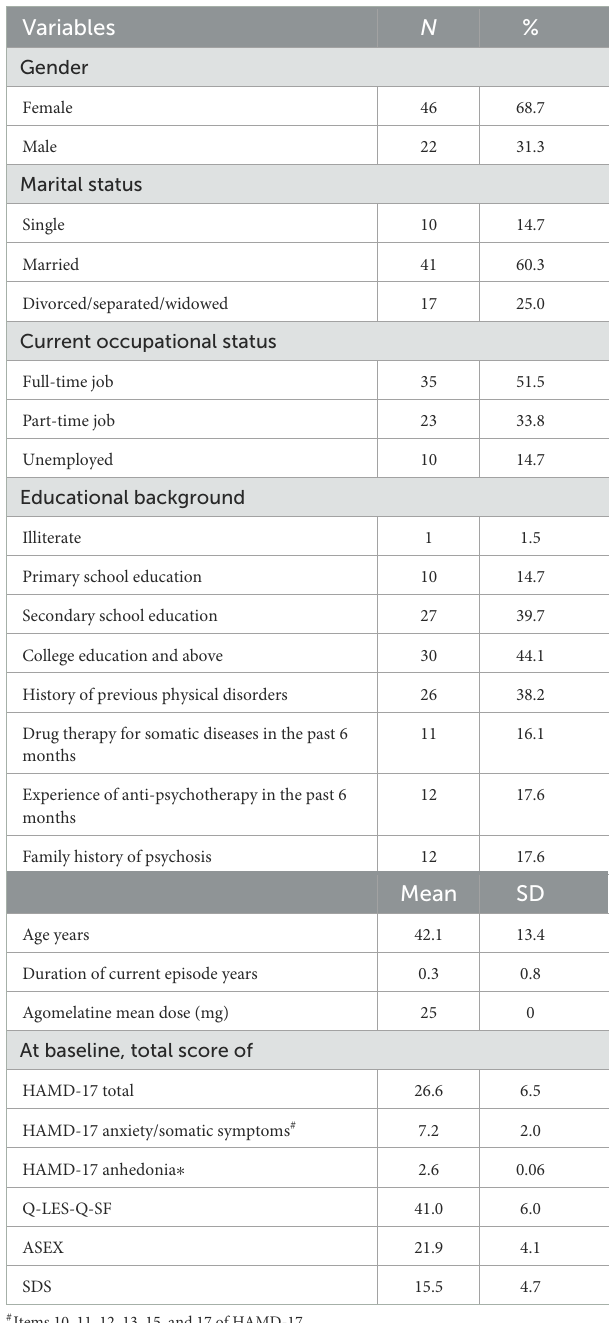
TABLE 1 Demographic characteristics of patients completing the trial at baseline ( N =